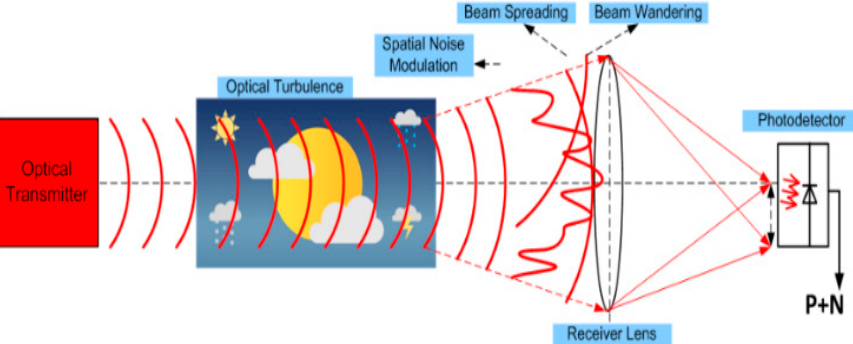
Figure 13. The results of turbulence e ff ects into signal reception by PD, producing noise instead of